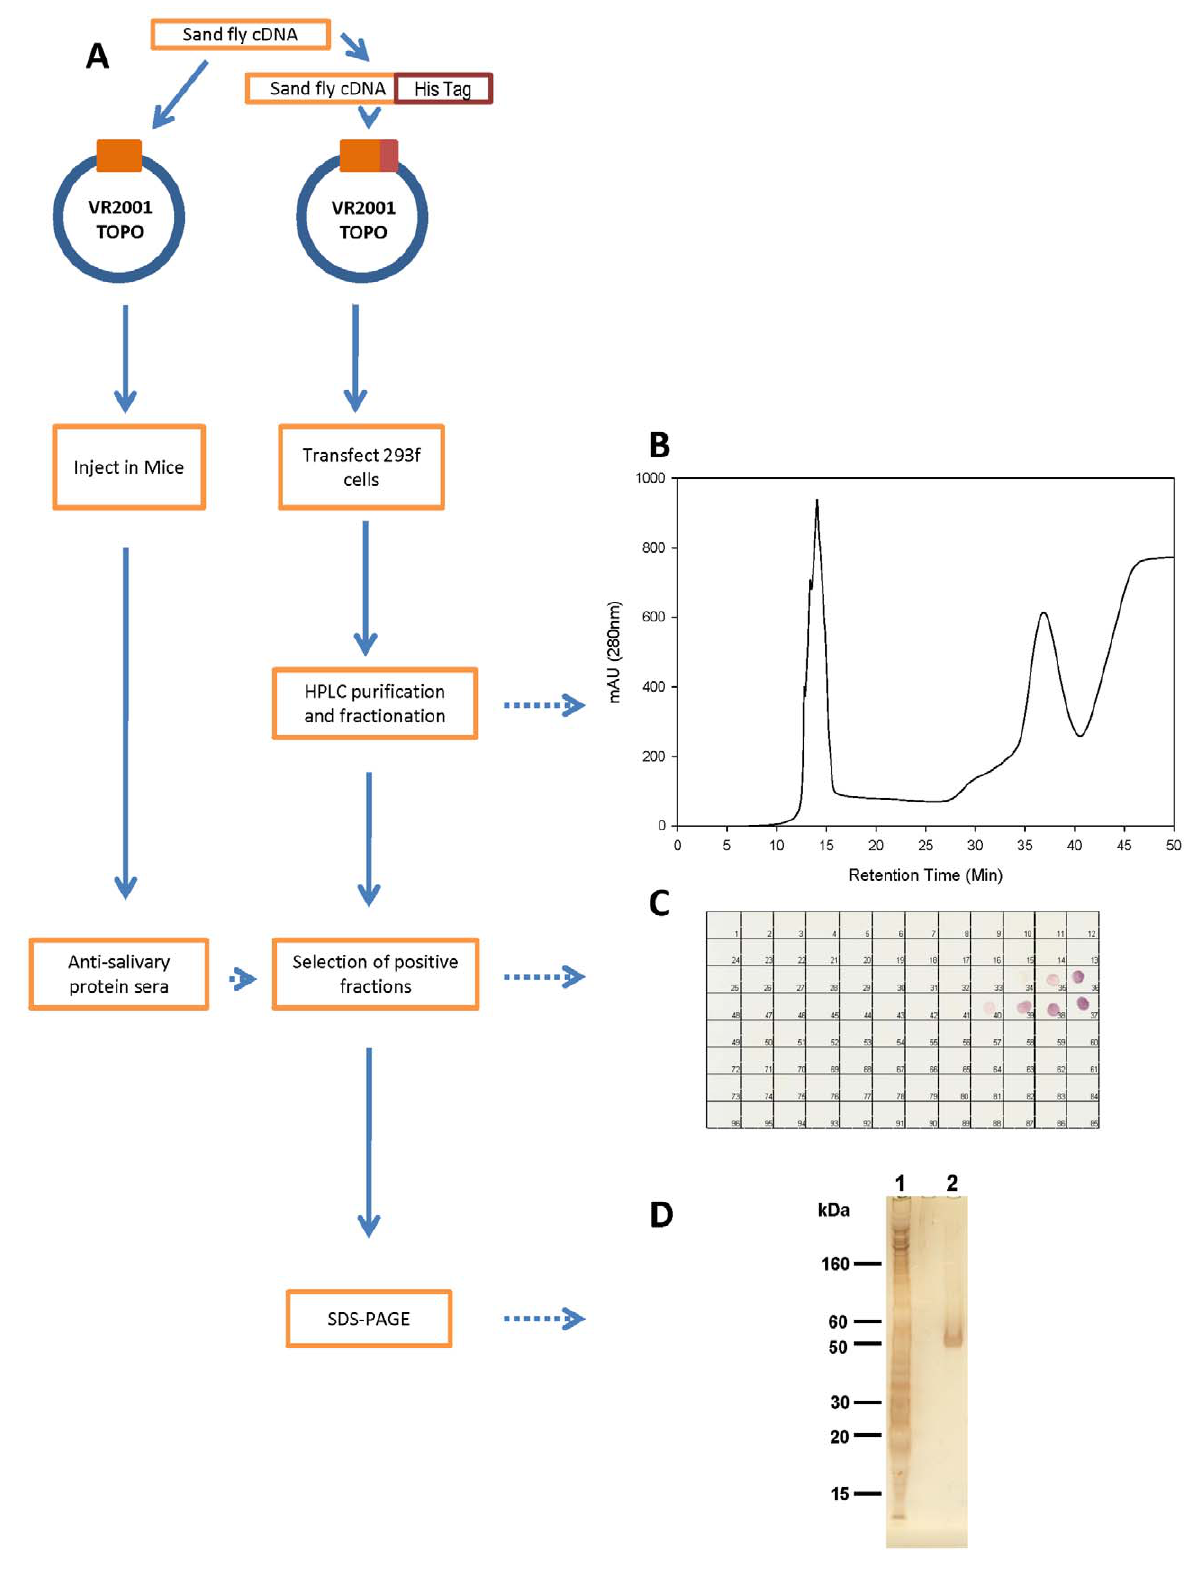
Figure 4. Production of recombinant sand fly salivary proteins. A , Flowchart describing the expression, purification and detection of recombinant sand fly salivary proteins from Lutzomyia longipalpis . B , Chromatogram of the purification of the LJM17 recombinant protein by HPLC- metal affinity chromatography. C , Detection of positive fractions for the LJM17 recombinant protein using sera from mice immunized with LJM17 plasmid. D , Silver-stained SDS-PAGE of LJM17 recombinant protein before (1) and after (2) HPLC purification.